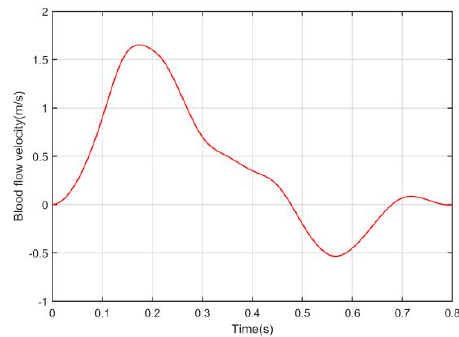
Figure 3. Changes in arterial blood velocity over time during a cardiac cycle [26-27].